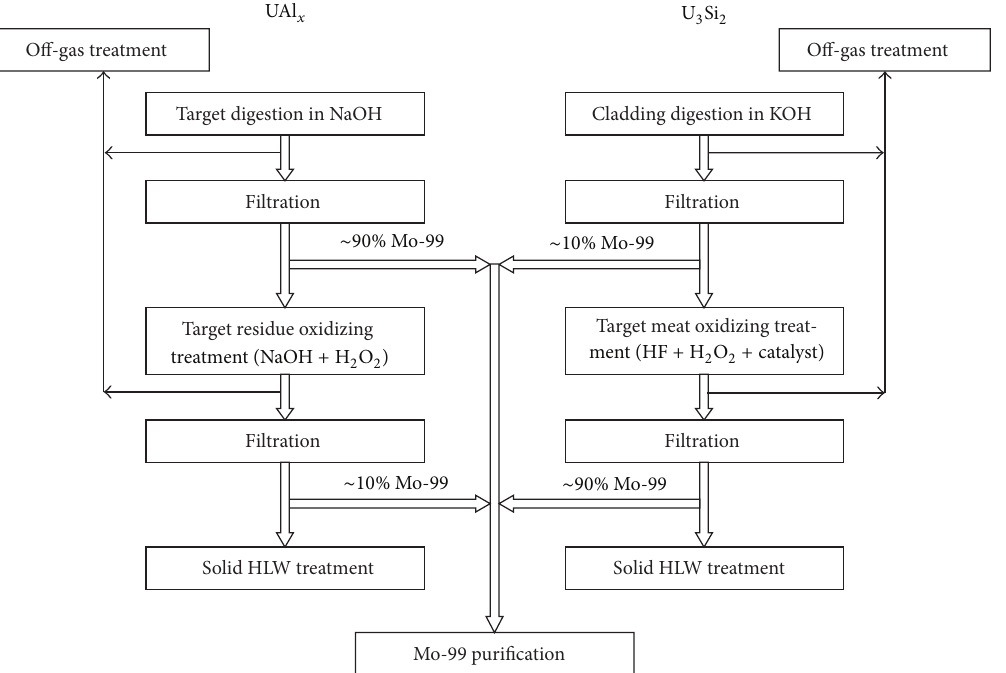
Figure 3: Flow scheme (in detail) of KSA/KSS production process showing the chemical treatment of UAl 𝑥 targets (left column) in comparison to other targets (right column, U 3 Si 2 taken as